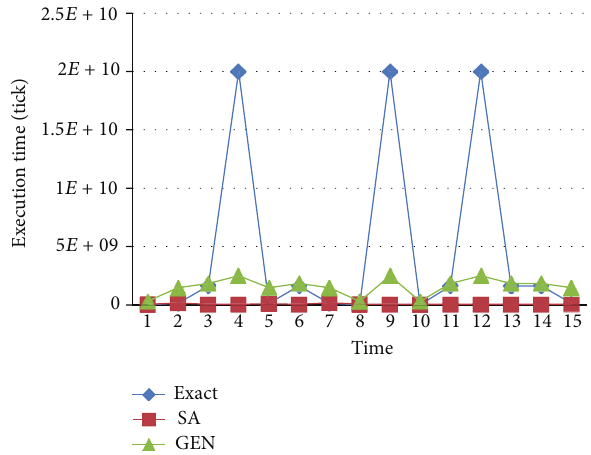
Figure17:Number Object/ 𝑇 200 ), and simulated annealing (fact = 0.95 ).